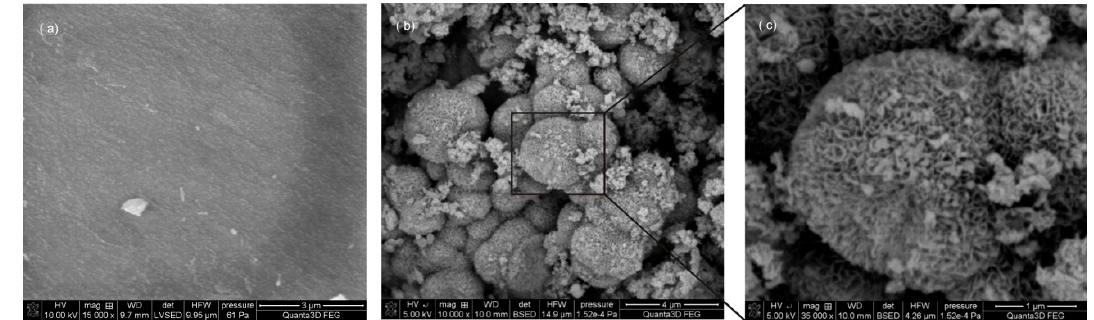
Figure 6. Scanning electron microscope (SEM) of ( a ) MCM-41 before mineralization studies, and ( b )- ( c ) MCM-41 after 1 month of mineralization studies in simulated body fluid.